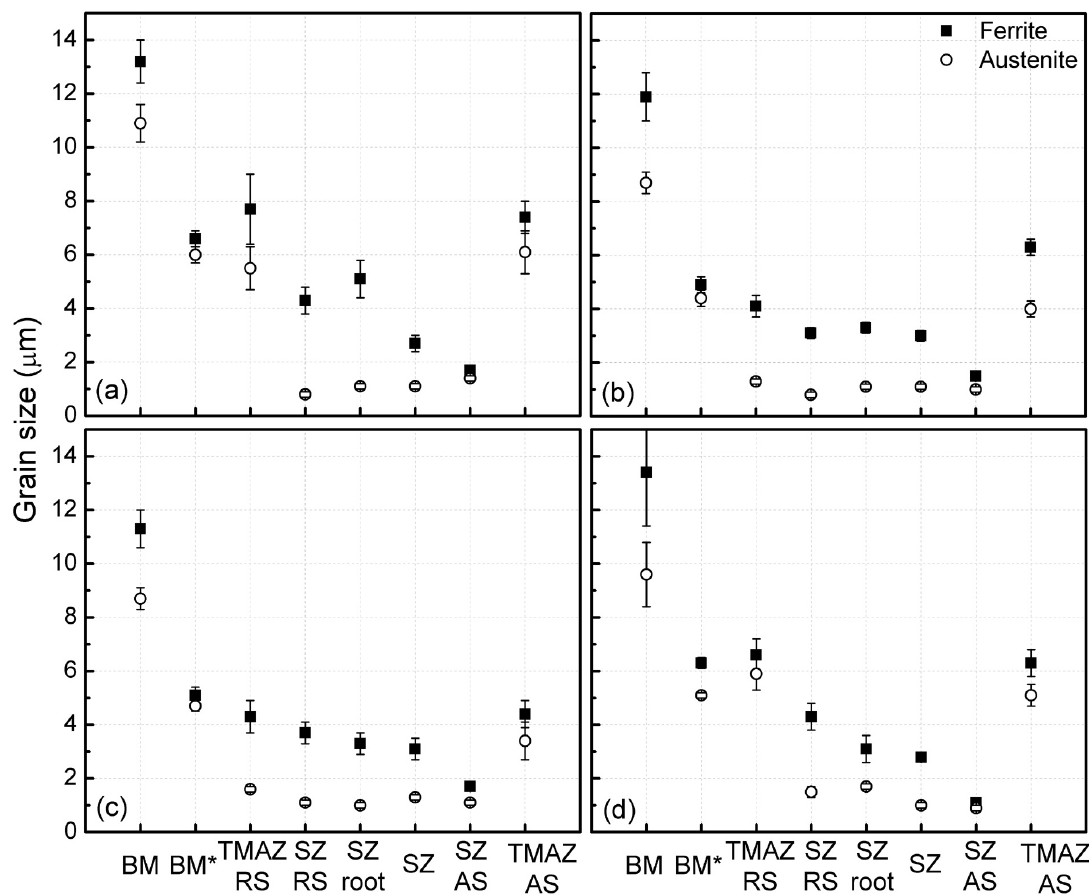
Fig. 12. Grain sizes for (a) S32101, (b) S32205, (c) S32750, and (d) S32760. BM is the base metal grain size and BM* is the thickness of the BM lamellae.